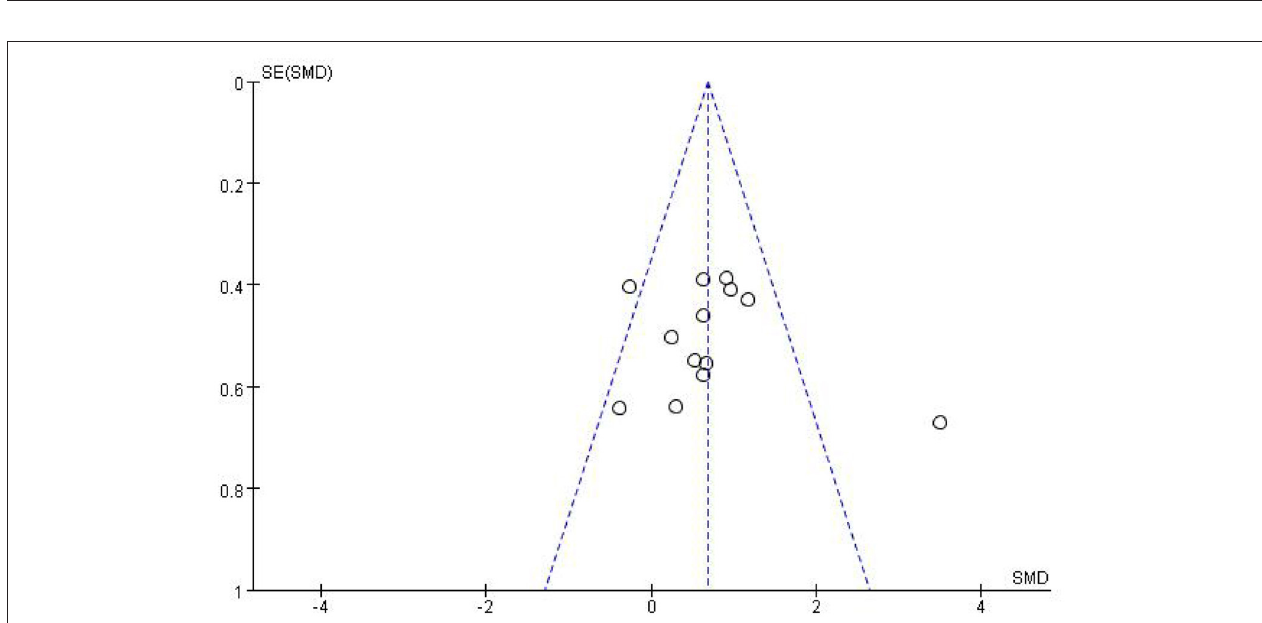
FIGURE 4 | Comparison of the effects of BCI interventions and control interventions on upper limb dysfunction before sensitivity analysis.